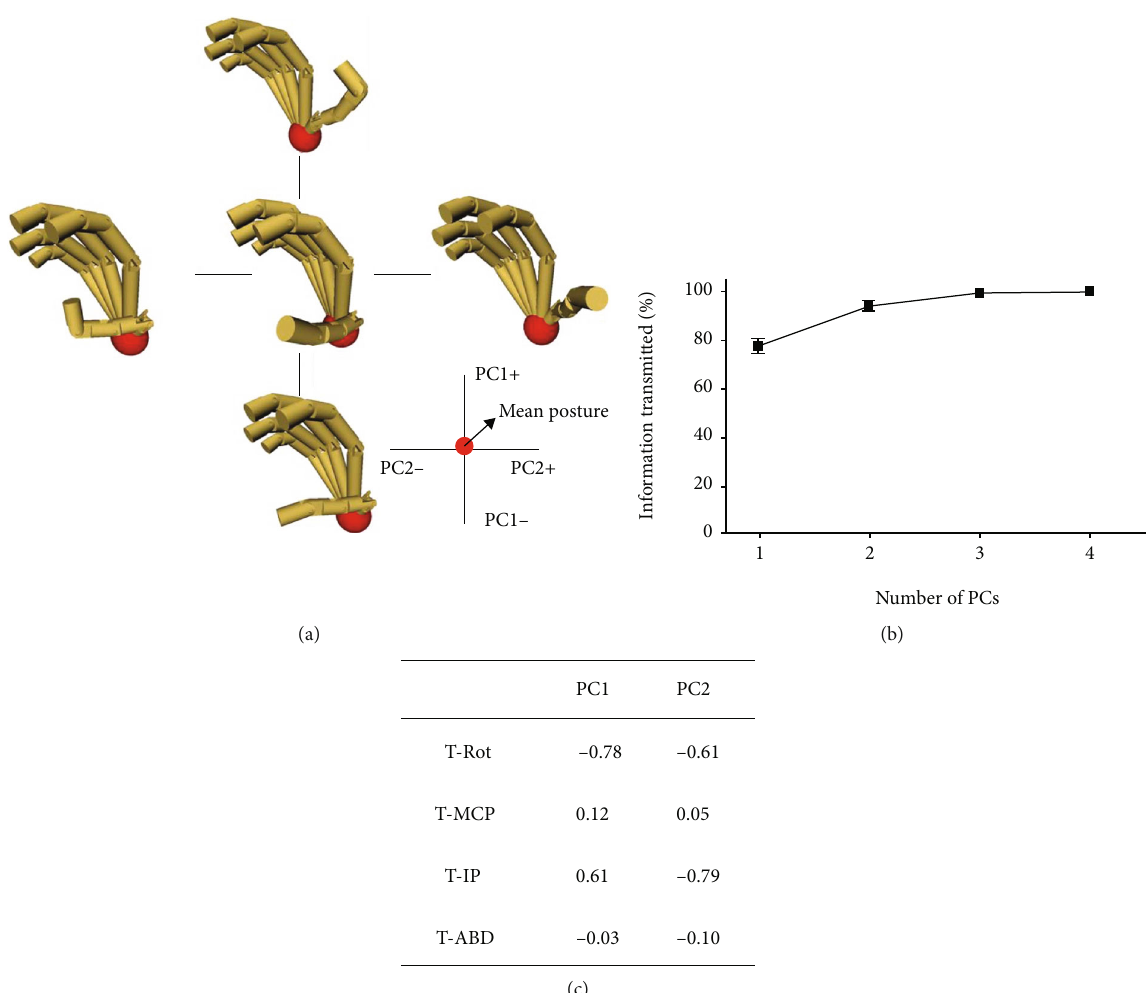
Figure 8: PCA on thumb posture: (a) thumb posture reconstruction by PC1-PC2; (b) information transmitted by PC1-PC4; (c) detailed element value of